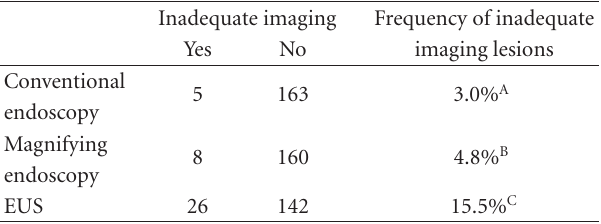
Table 3: Comparison of the frequencies of lesions with endoscopic images those were di ffi cult to diagnosis among 3 di ff erent endo- scopic techniques (conventional endoscopy, magnifying endoscopy, and EUS).